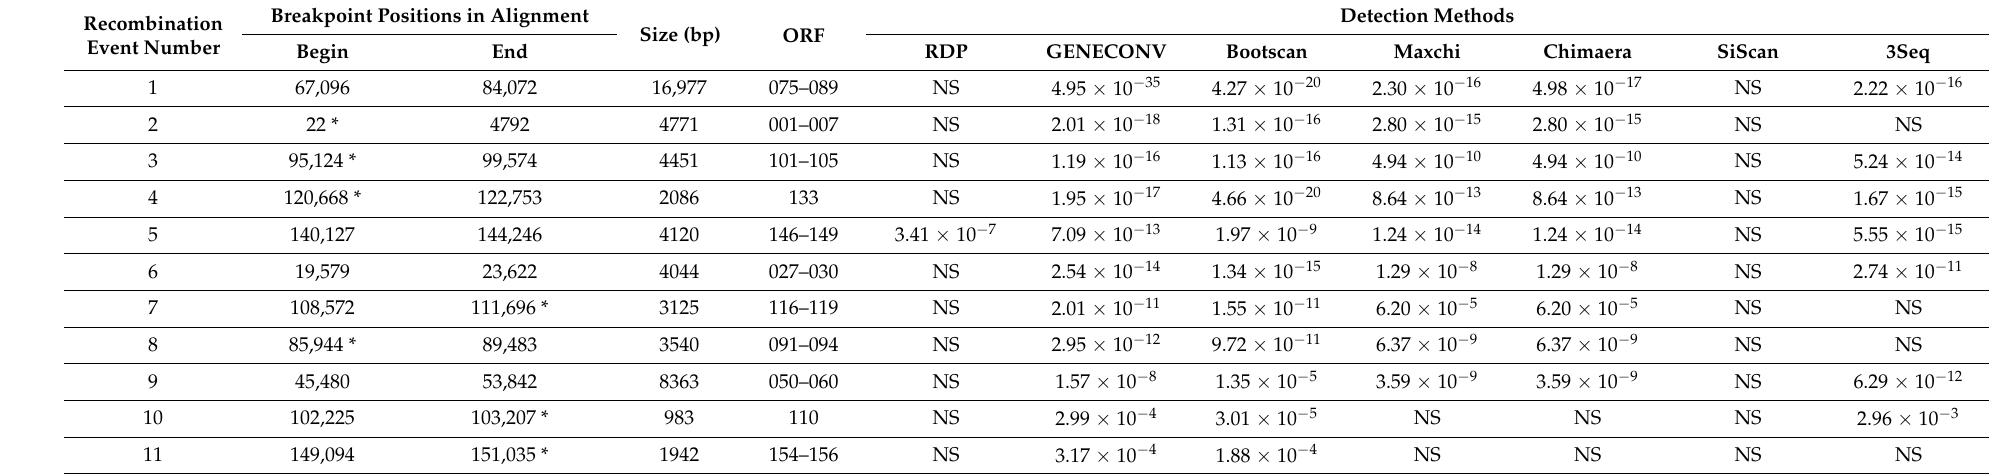
Table 2. Predicted recombination events determined by different detection methods available in the RDP4